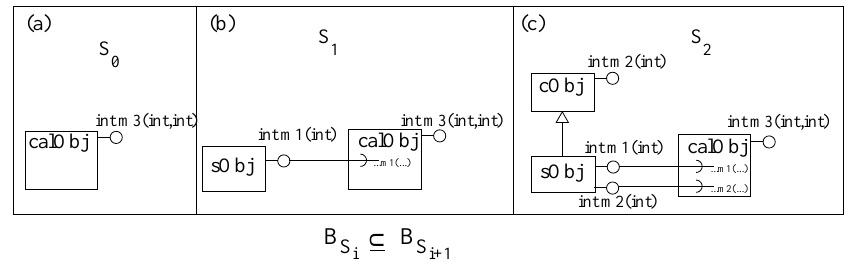
Figure 12. A system to evaluate a mathematical expression: ( a ) S 0 , ( b ) S 1 and ( c ) S 2